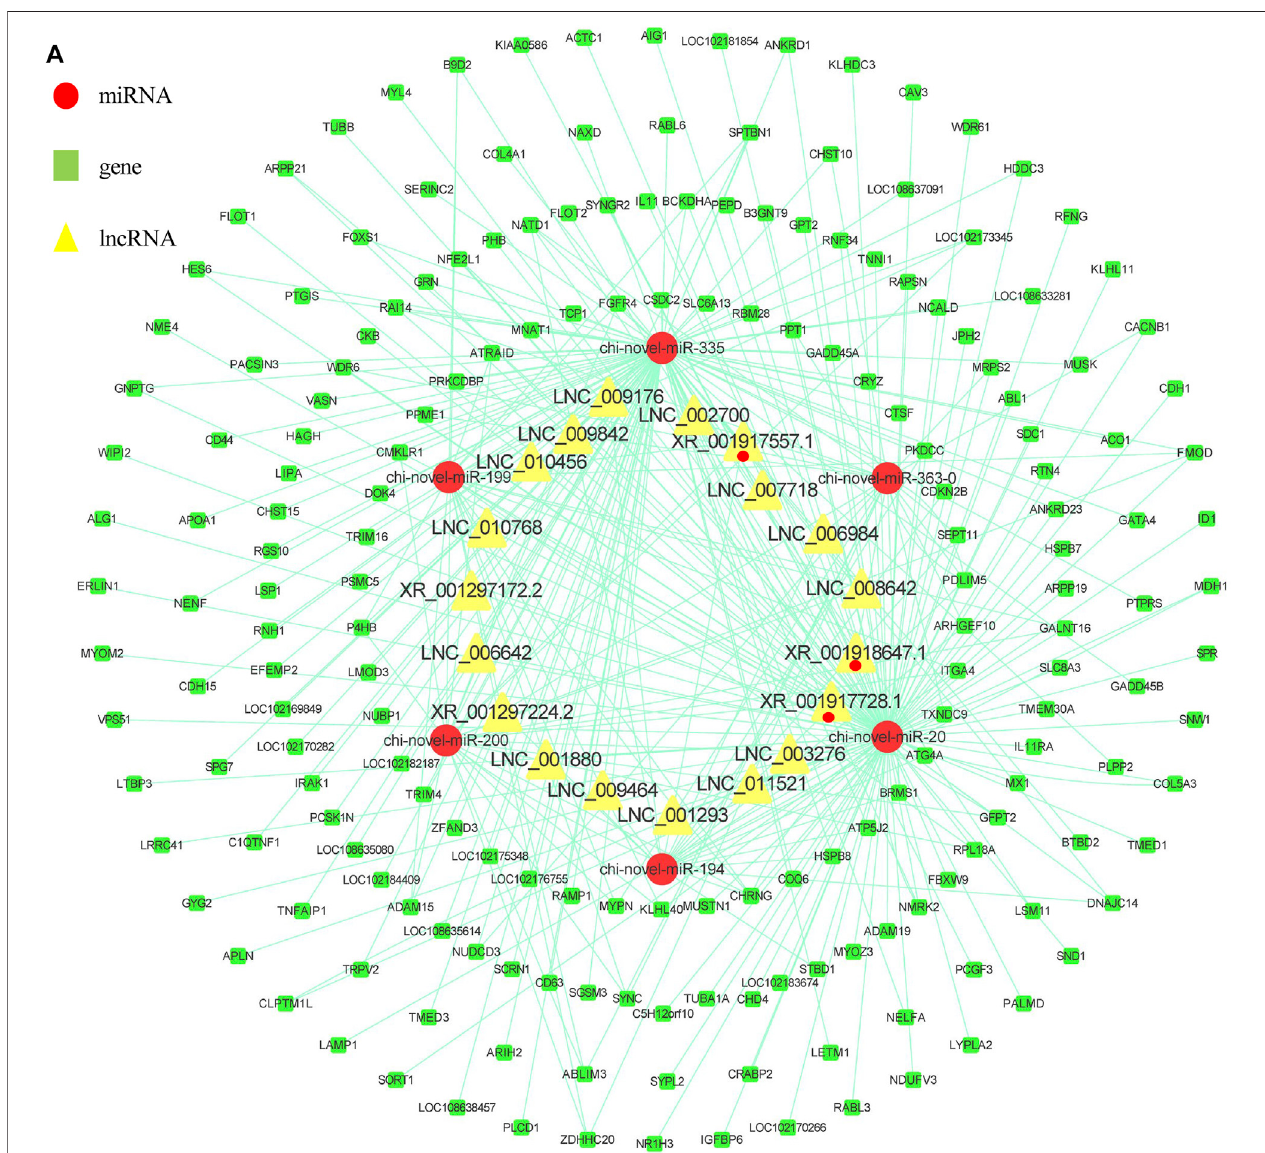
FIGURE6| lncRNA – miRNA – mRNAnetwork. (A) Regulatorynetworkofintramuscularadipocytesbeforeand afterdifferentiation. NodeswithClosenessCentrality > 6.4815E-4 are discarded. Closeness Centrality is the reciprocal of the sum of the shortest paths from a point to all other points, and the larger it is, the shorter the path from thatpointtoallotherpointsand thecloser itistothecenterinspace. (B) Regulatorynetworkofsubcutaneousadipocytesbeforeandafter differentiation. (C) There is a common network of intramuscular and subcutaneous adipocytes before and after differentiation.